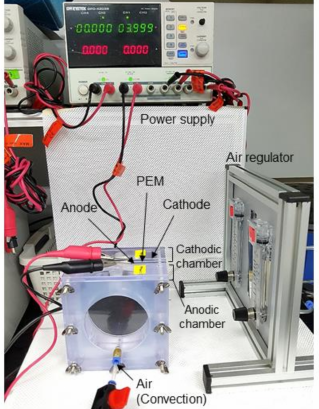
Figure 1. The two-chamber bioelectrochemical system equipped with DC power supply and an aeration control unit [19]. PEM, proton-exchange